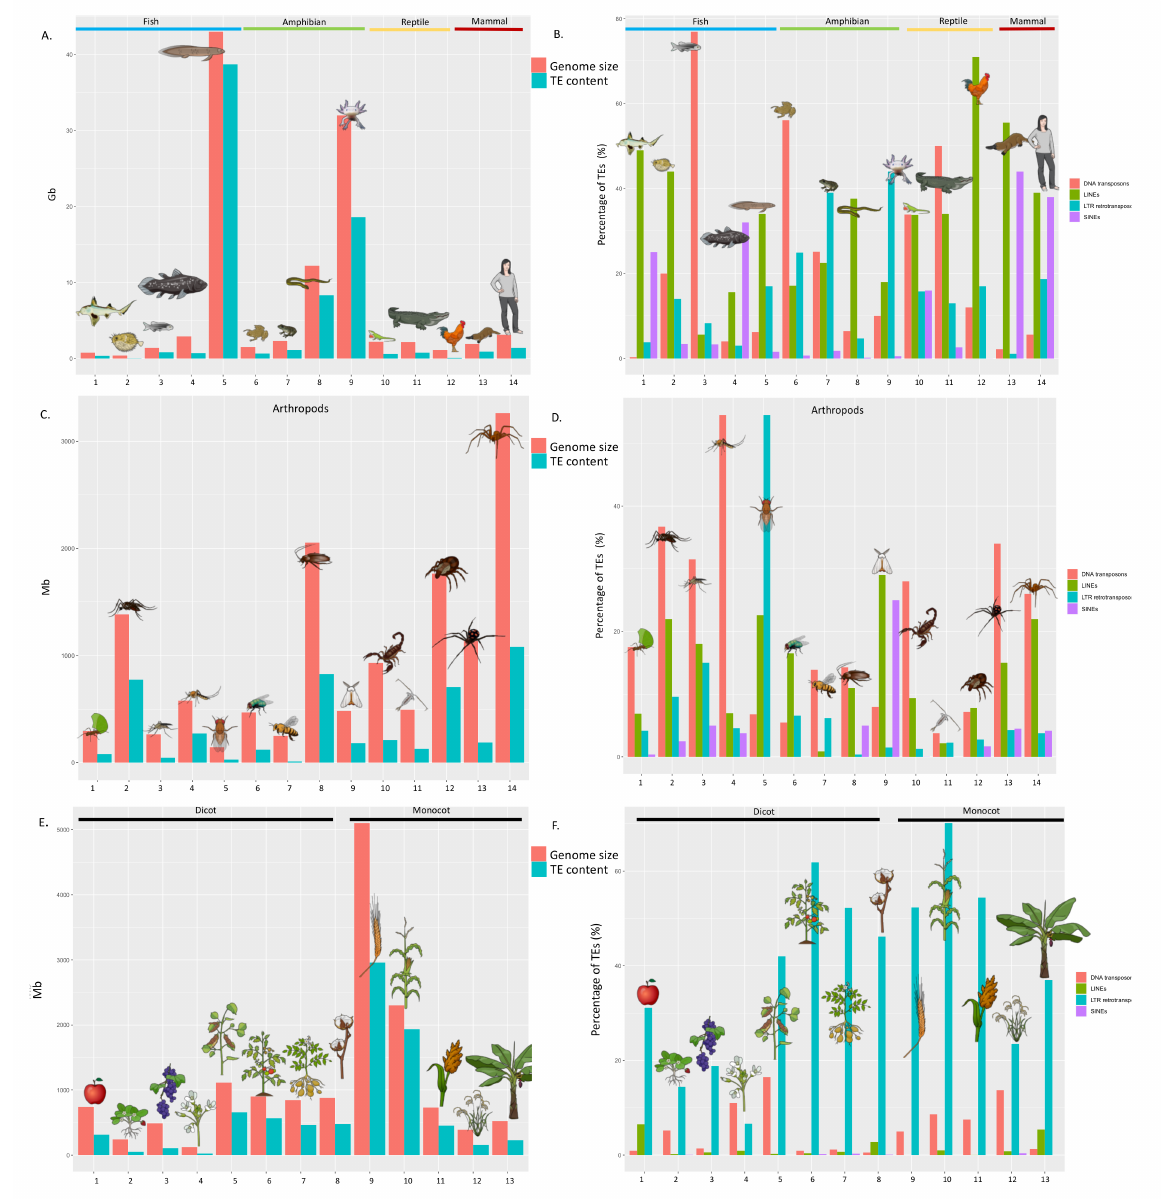
Figure 1. Genome size and its TE content across different organisms. ( A ) Genome size and its TE content in Gb across different vertebrates, from left to right: (1) Callorhinchus milii , (2) Tetraodon nigroviridis , (3) Danio rerio , (4) Latimeria chalumnae , (5) N. forsteri , (6) Xenopus tropicalis , (7) Nanorana parkeri , (8) Ichthyophis bannanicus , (9) Ambystoma mexicanum , (10) Anolis carolinensis , (11) Alligator mississipiensis , (12) Gallus gallus , (13) Ornithorhynchus anatinus , and (14) Homo sapiens . ( B ) Percent- ages of TEs types (DNA transposons, LINEs, LTR retrotransposons, and SINEs) of the vertebrates presented in ( A ). ( C ) Genome size and its TE content in Mb across different arthropods, from left to right: (1) Acromyrmex echinatior , (2) Aedes aegypti , (3) Anopheles gambiae , (4) Culex quinquefasciatus , (5) Drosophila melanogaster , (6) Lucilia cuprina , (7) Apis mellifera , (8) Blattella germanica , (9) Bombyx mori , (10) Centruroides exilicauda , (11) Eurytemora affinis , (12) Ixodes scapularis , (13) Latrodectus Hesperus and 14) Loxosceles reclusa . ( D ) Percentages of TEs types of the arthropods presented in ( C ). ( E ) Genome size and its TE content in Mb across different plants, from left to right: (1) Malus domestica (2) Fragaria vesca , (3) Vitus vinifera , (4) Arabidopsis thaliana , (5) Glycine max , (6) Solanum lycopersicum , (7) Solanum tuberosum , (8) Gossypium raimondii , (9) Hordeum vulgare (10) Zea mays , (11) Sorghum bicolor , (12) Oryza sativa and (13) Musa acuminate. ( F ) percentages of TEs types of the plants presented in ( E ). Data from